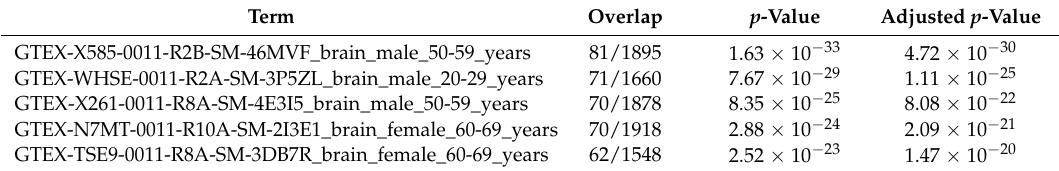
Table 9. Top ranked five gene expression profiles in “Genotype-Tissue Expression (GTEx) Tissue Sample Gene Expression Profiles up” whose altered genes are associated with 244 gene symbols.